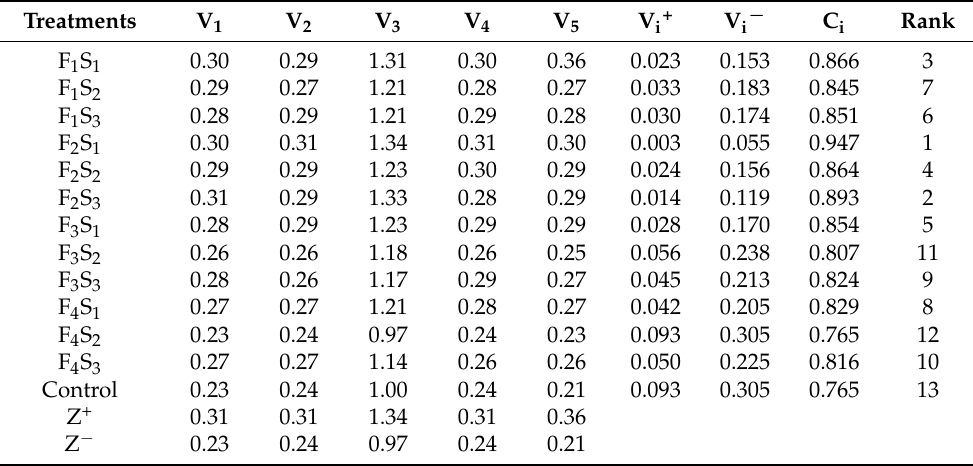
Table 9. TOPSIS analysis of the number of flower clusters and number of fruits per plant, fruit yield, average fruit weight, and water use efficiency for different fertigation levels and scheduling methods for tomato plants under polyhouse condition.